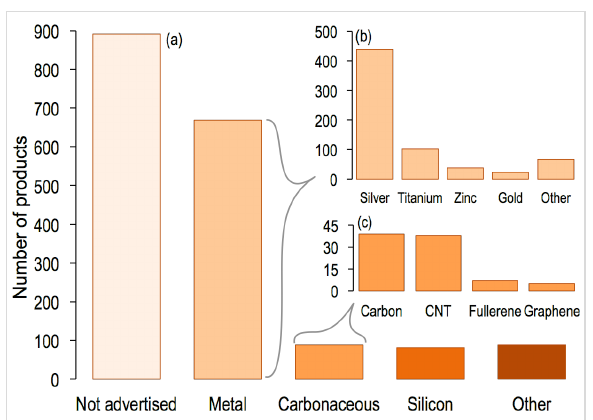
Figure 2: (a) Claimed composition of nanomaterials listed in the CPI, grouped into five major categories: not advertised, metal (including metals and metal oxides), carbonaceous nanomaterials (carbon black, carbon nanotubes, fullerenes, graphene), silicon-based nanomaterials (silicon and silica), and other (organics, polymers, ceramics, etc.). (b) Claimed elemental composition of nanomaterials listed in the metals category: silver, titanium, zinc, gold, and other metals (magne- sium, aluminum oxide, copper, platinum, iron and iron oxides, etc.). (c) Claimed carbonaceous nanomaterials (CNT = carbon nanotubes). The percentages of nanomaterial compositions in the CPI 2.0